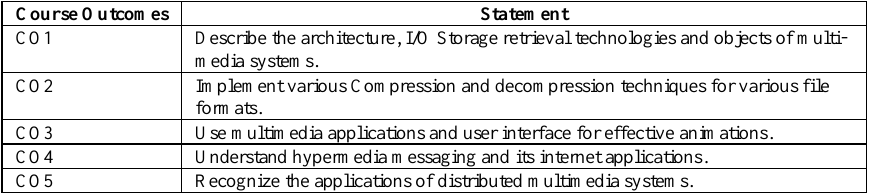
Table 1. Course outcome statements for Multimedia System Course